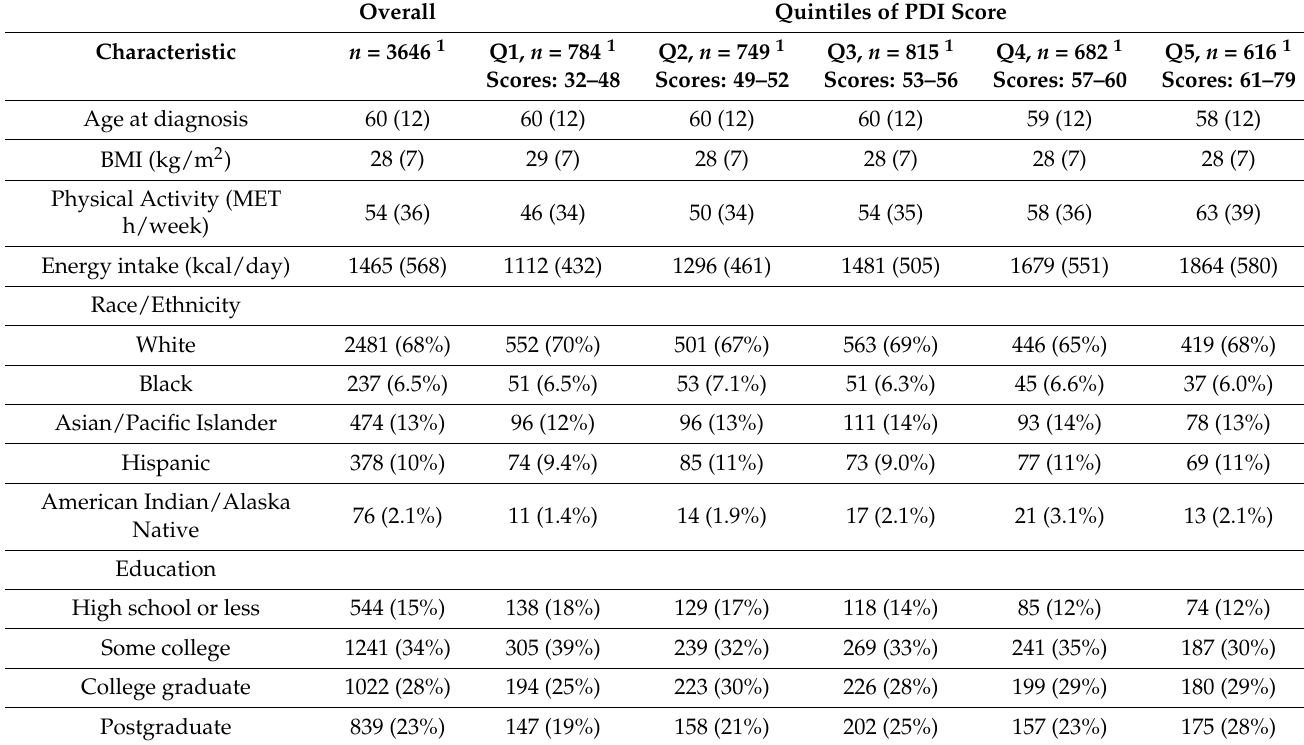
Table 1. Baseline characteristics of participants by plant-based diet index (PDI) quintiles, Pathways Study. Overall Quintiles of PDI Score